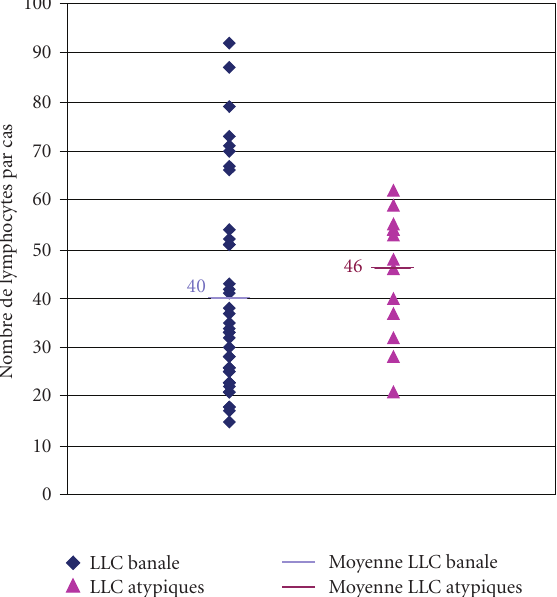
Figure 8: Number of pictures taken functions of the